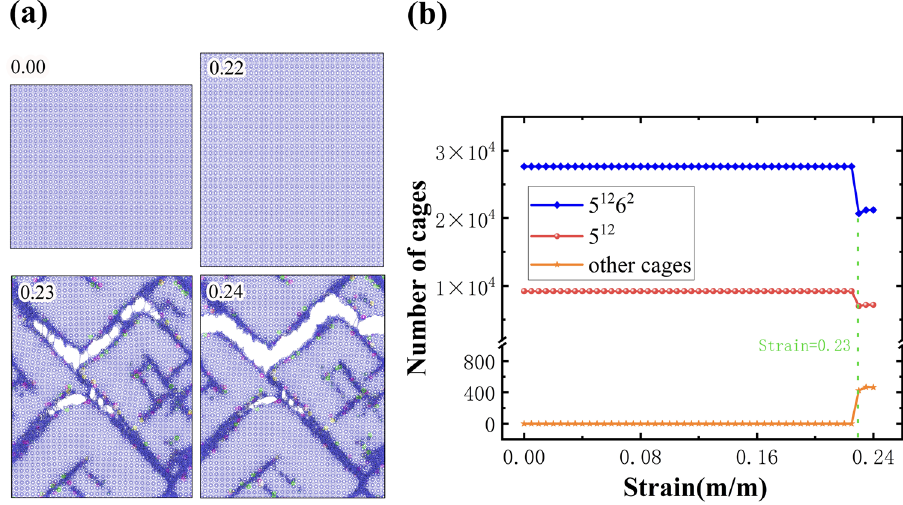
Figure 10: ( a ) Snapshots of strains ε = 0.00, 0.22, 0.23, and 0.24 of the sI - type clathrate hydrate system ( with 211,968 water molecules ) . ( b ) Number of di ff erent cages identi fi ed by the HTR algorithm as a function of